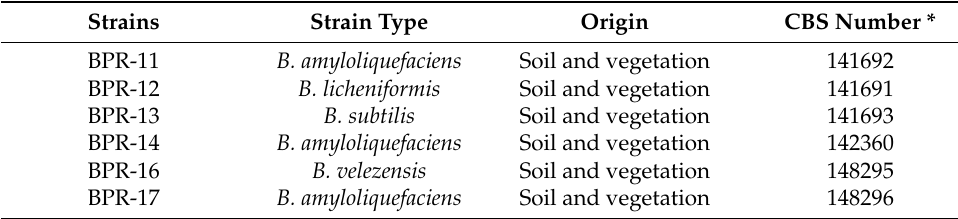
Table 1. Bacillus strains, origins and CBS